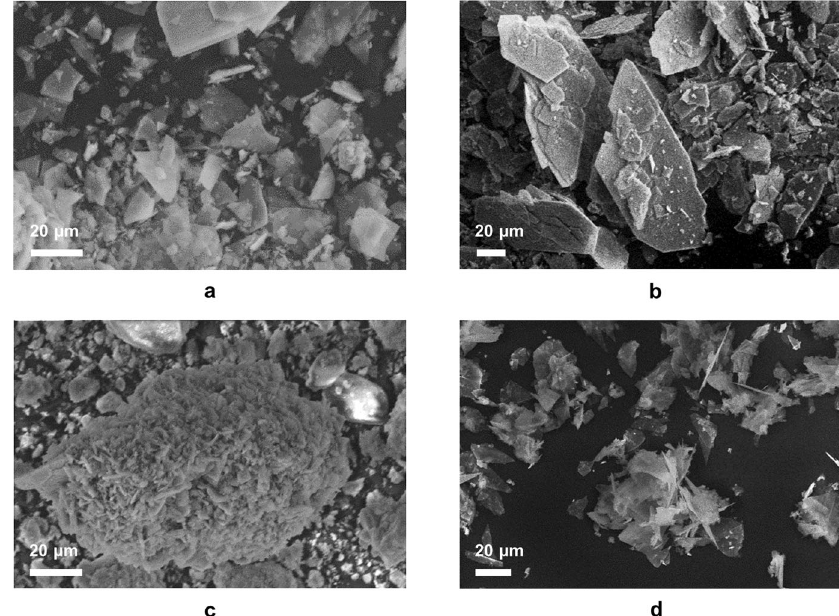
Fig. 8 SEM images of ( a ) DCPD grown on DCPD seed material ( b ) DCPD grown on DCPD seed in the presence of alanine ( c ) DCPD grown on DCPD in the presence of glutamic acid and ( d ) DCPD grown under spontaneous conditions (labile